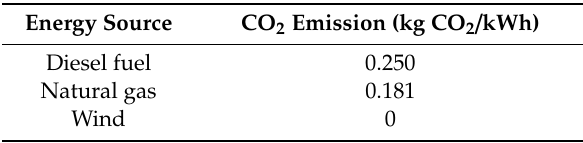
Table 10. CO 2 emissions associated with generation of 1 kWh of energy from natural gas, diesel, and wind energy.